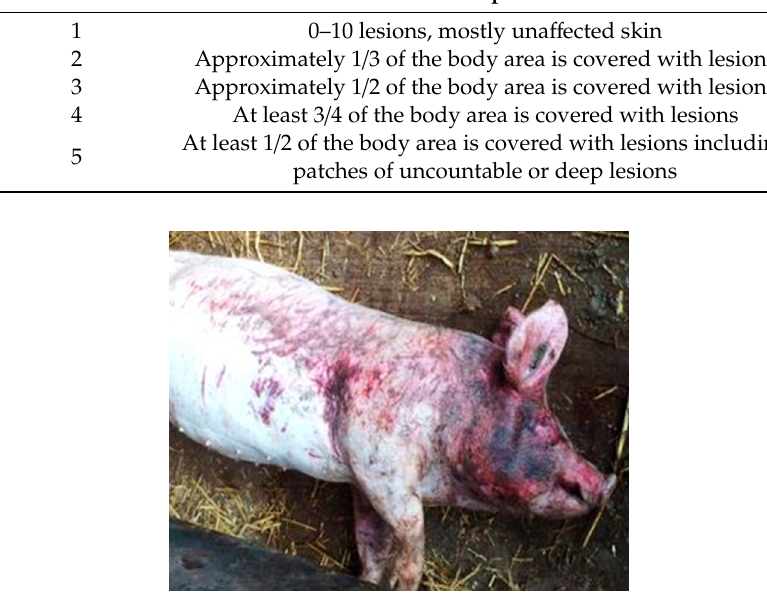
Table 1. Lesion score method, adapted for the severity of lethal gang aggression.